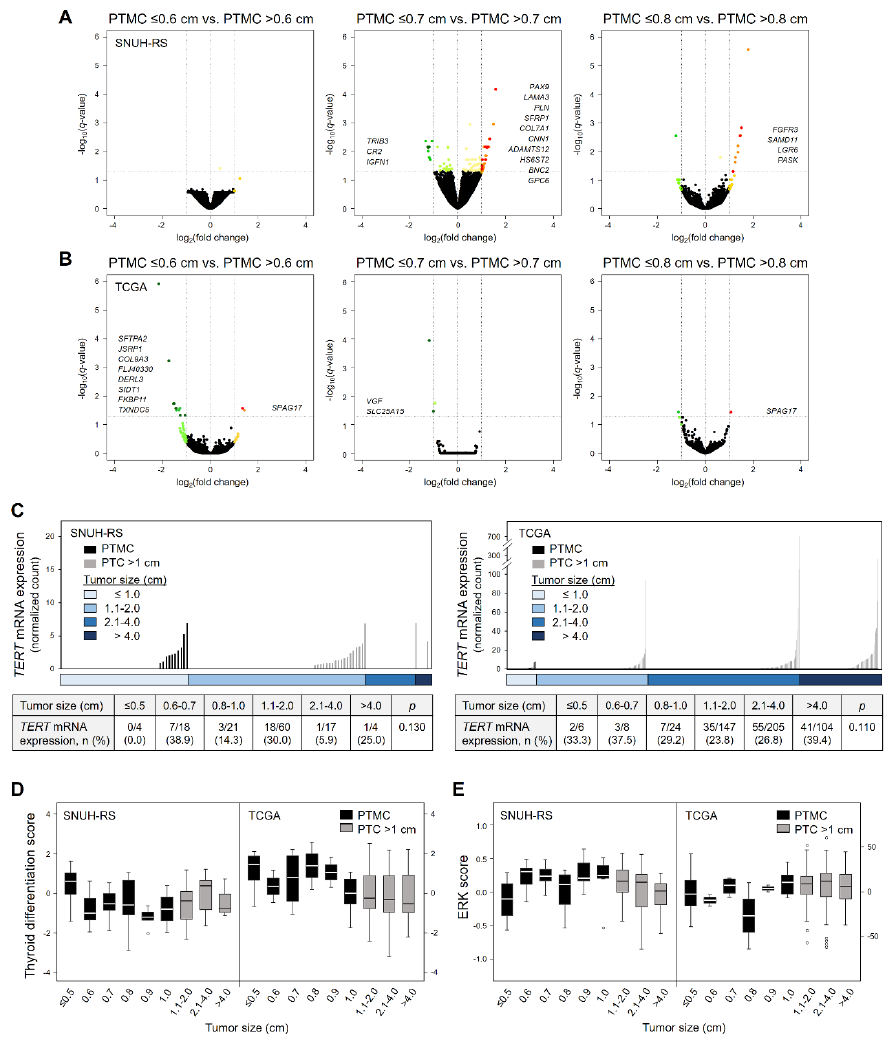
Figure 3. Transcriptomic characteristics of papillary thyroid microcarcinoma according to tumor size. Volcano plots showing differential RNA expression levels between groups of all PTMCs: ≤0.6 cm vs. >0.6 cm (left), ≤0.7 cm vs. >0.7 cm (middle), and ≤0.8 cm vs. >0.8 cm (right) from the ( A ) SNUH RNA-sequencing (SNUH-RS, n = 13 vs. 30, 22 vs. 21, 32 vs. 11, respectively) and ( B ) TCGA ( n = 9 vs. 30, 14 vs. 25, 17 vs. 22, respectively) datasets. ( C ) TERT mRNA expression levels according to tumor size (upper graph) from both datasets. Each column represents an individual sample. The number of cases with TERT mRNA expression according to tumor size (lower table). Thyroid di ff erentiation score ( D ) and ERK score ( E ) according to tumor size from both datasets ( n = 124 and 496 for SNUH-RS and TCGA datasets, respectively). PTMC, papillary thyroid